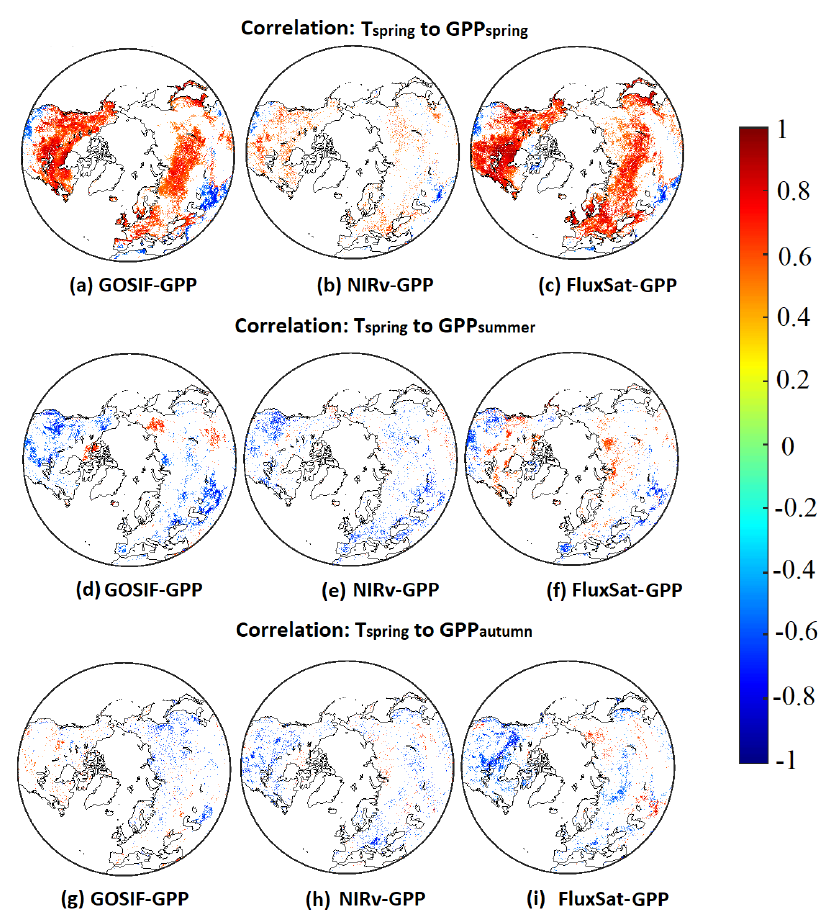
Figure 2. Pearson’s correlations ( p < 0.05) between T spring anomalies and GPP spring ( a – c )/ GPP summer ( d – f )/ GPP autumn ( g – i